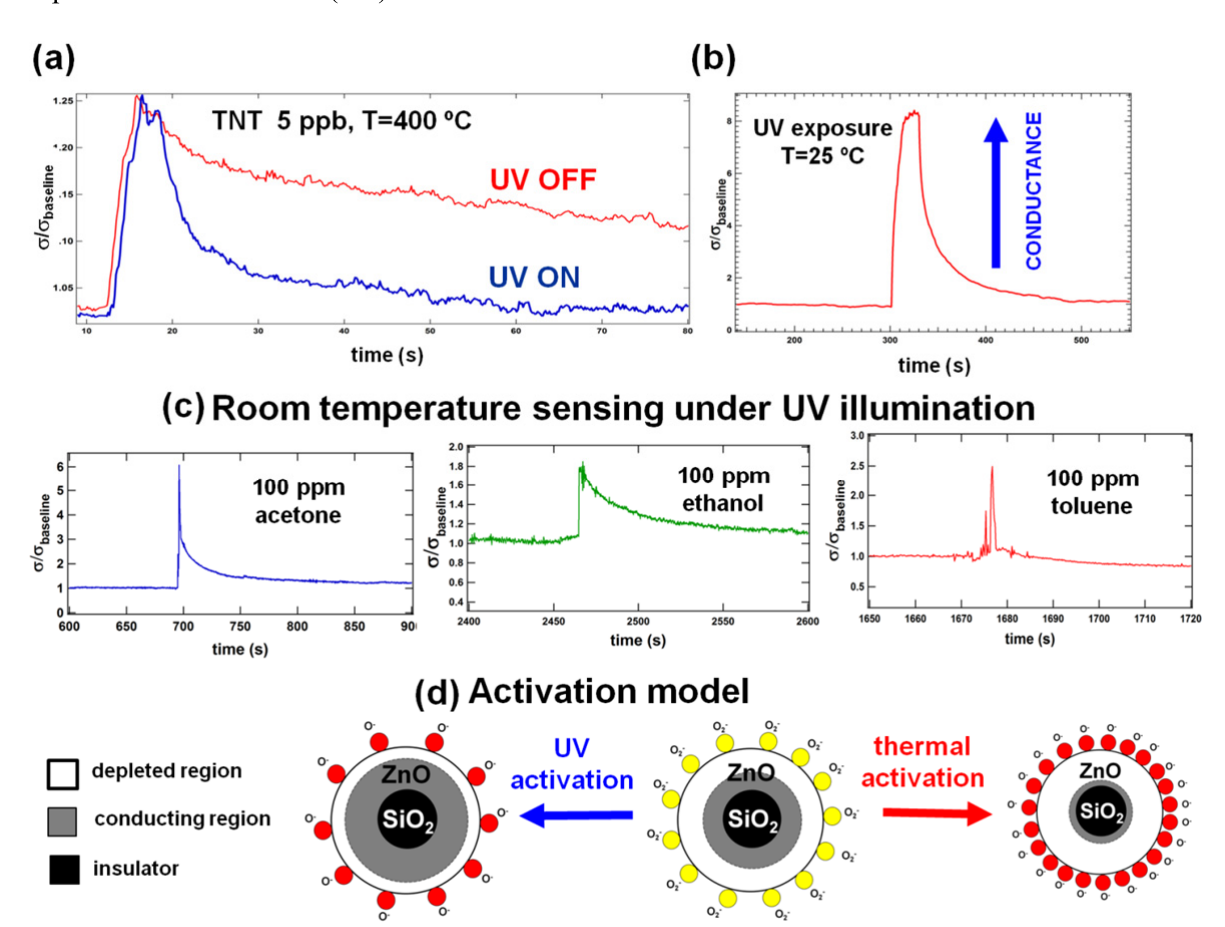
Figure 6. ( a ) The relative change in conductance of a thermally activated Pd/ZnO nanospring sensor upon exposure to TNT at 5 ppb and exposure pulses of 0.1 ms. The upper desorption curve corresponds to a self-reset, and the lower one corresponds to a reset upon the UV exposure; ( b ) The relative change in conductance of Pd/ZnO nanospring sensor upon a 20 s UV exposure in the ambient atmosphere at room temperature; ( c ) The relative change in conductance of a UV activated Pd/ZnO nanospring sensor upon exposure to vapor-phase analytes at 100 ppm and an exposure pulse of 1 s; ( d ) A cross-section view of a nanowire showing the size of the conducting region (grey) with no activation at room temperature (center), upon the thermal activation (right), and upon the UV-activation